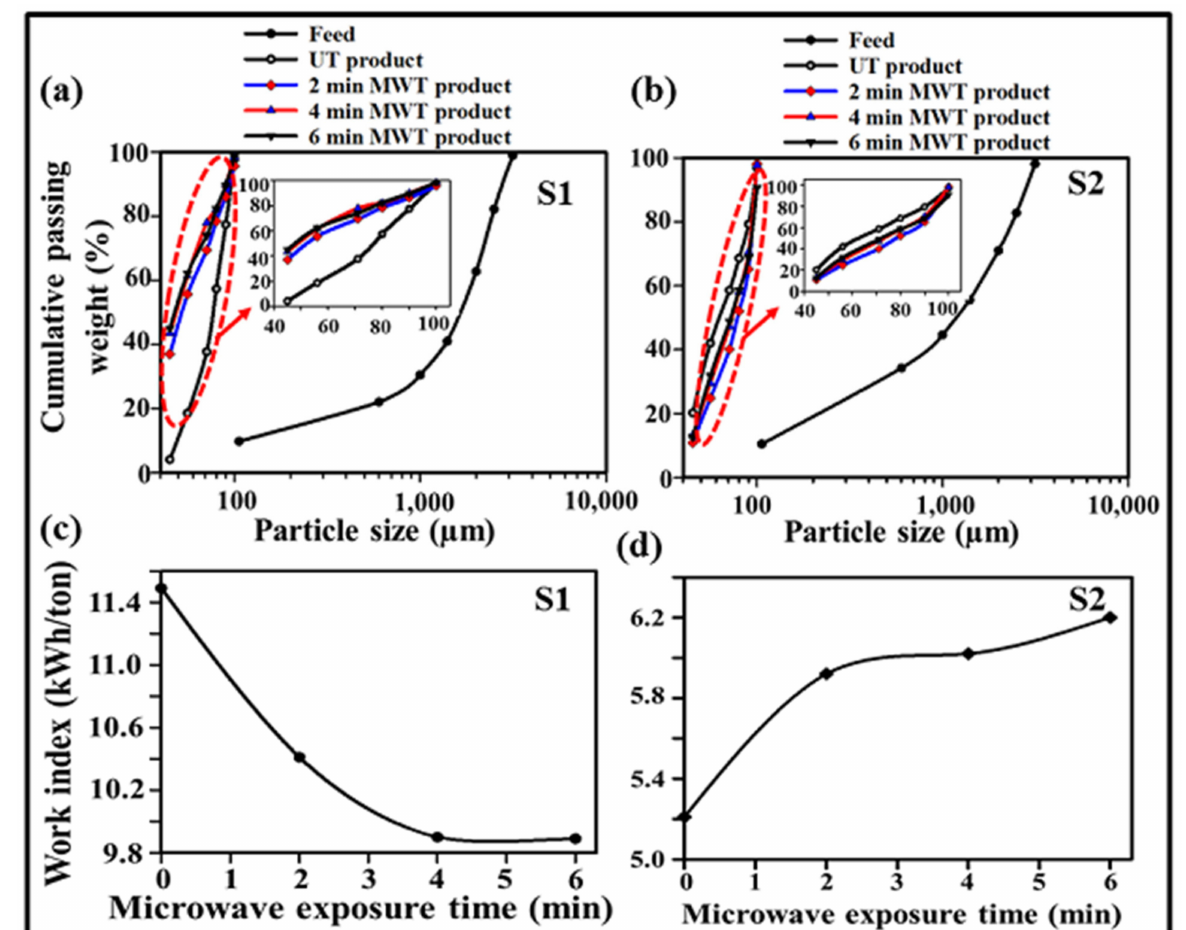
Figure 3. ( a , b ) Particle size distribution of the feeds and standard Bond ball mill grindability test of steady-state products, ( c , d ); work indices of the studied samples (microwave treatment conditions: 2.45 GHz, 1.7